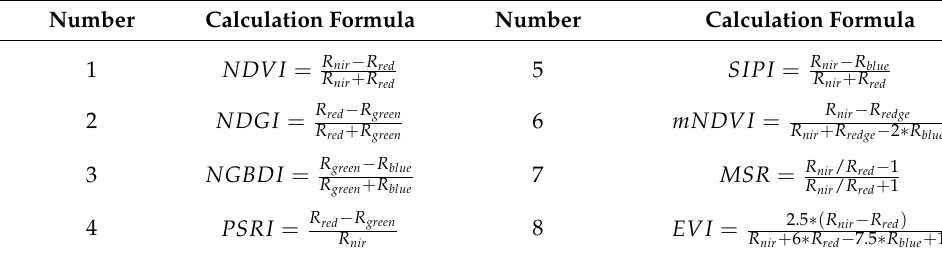
Table 2. Calculation formula of 8 spectral indexes.